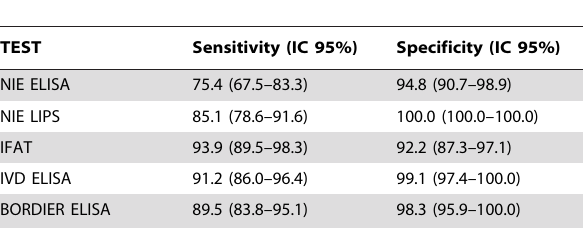
Table 2. Test accuracy on samples from subjects with certain diagnosis (denominator for sensitivity: 114 subjects with Ss larvae in stool; denominator for specificity: 115 subjects with no Ss larvae in stool and no